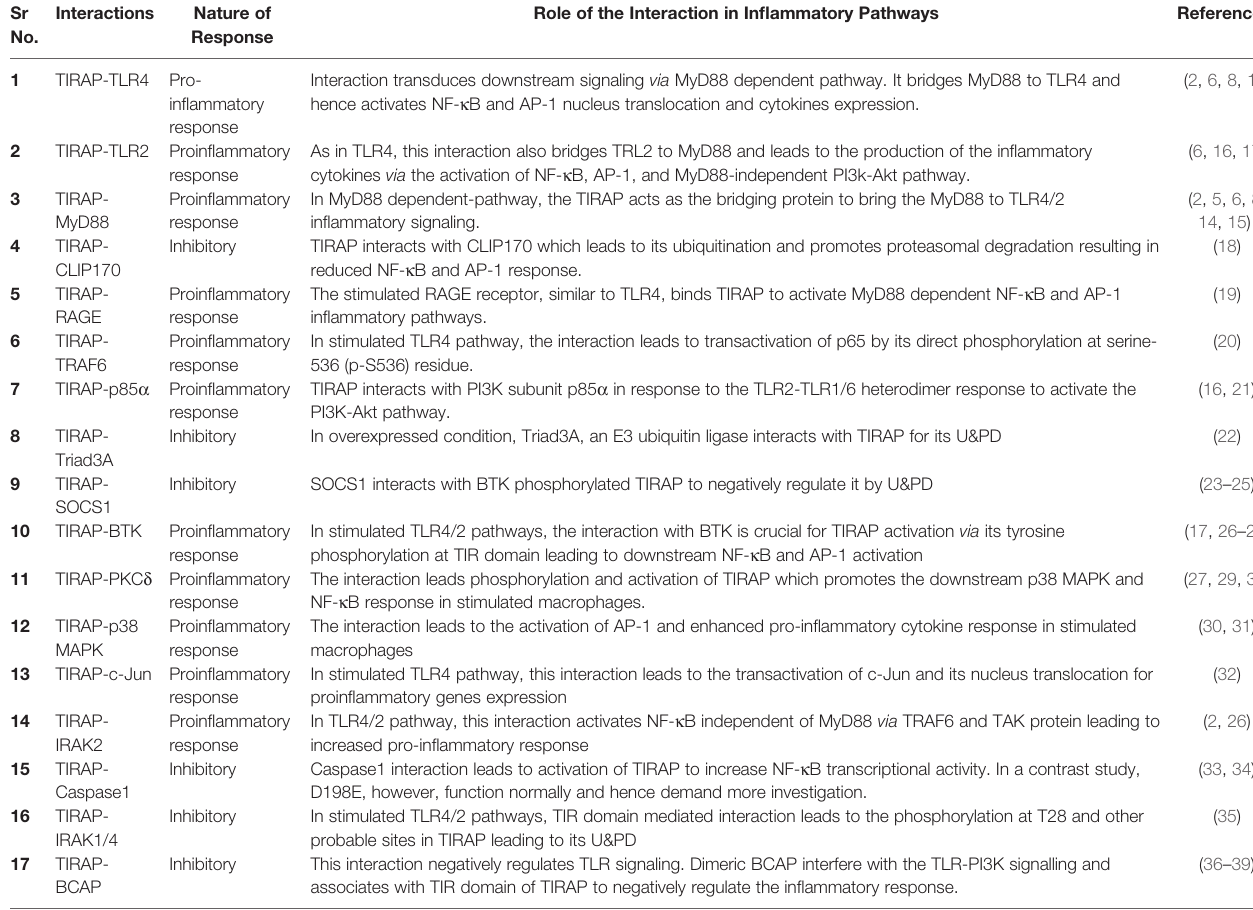
TABLE 1 | The signi fi cance of TIRAP interaction with the partner proteins in the cellular process. Sr No.